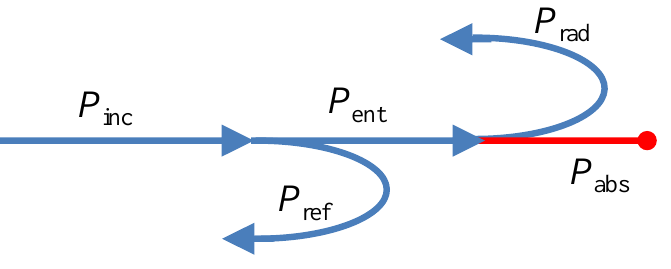
Figure 5. Power balance in the analyzed MPSS.